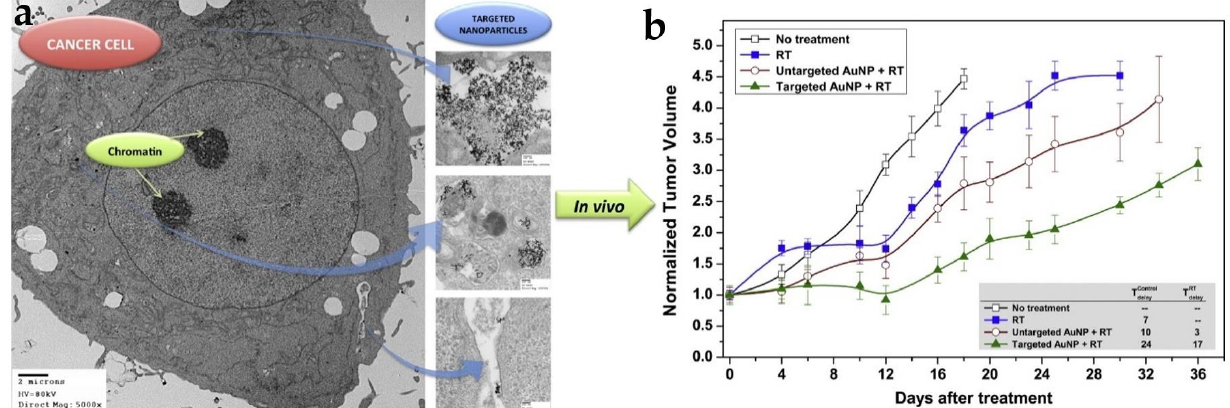
Figure 3. Gold nanoparticle (GNP)-mediated radiotherapy (RT). ( a ) TEM image of a prostate cancer with internalized gold nanorods. ( b ) In vivo radiosensitization of gold nanorod-incorporated tumor with megavoltage X-rays results in a substantial increase in tumor growth delay. This foretells the possibility of clinical translational of this nanomedicine approach to enhance RT. Reproduced with permission from [18], Elsevier,